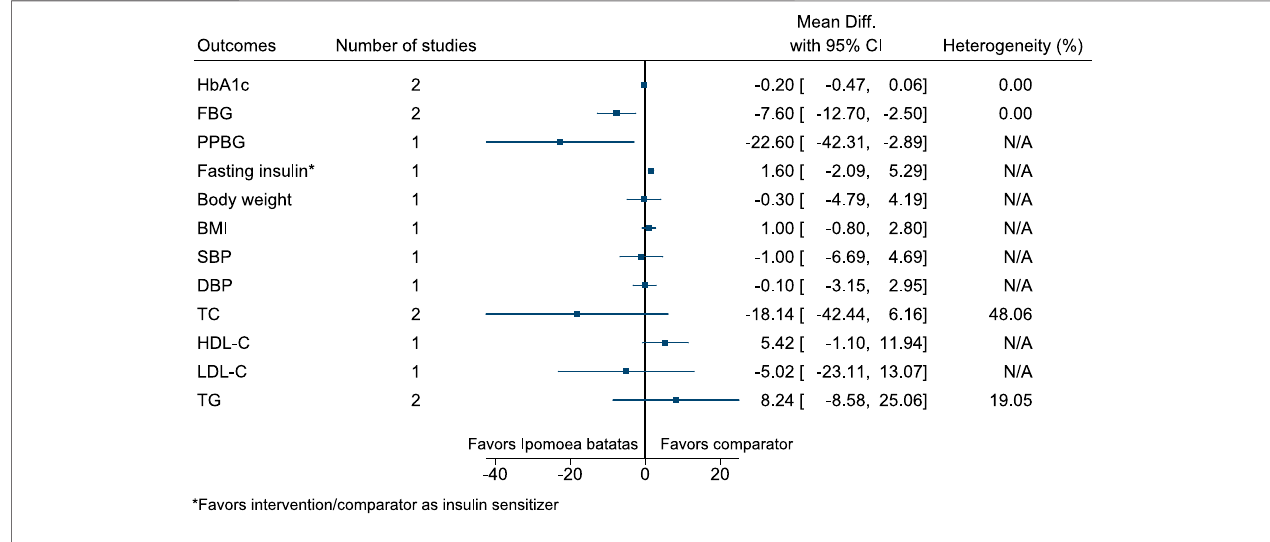
FIGURE 20 | Ipomoea batatas — Summary forest